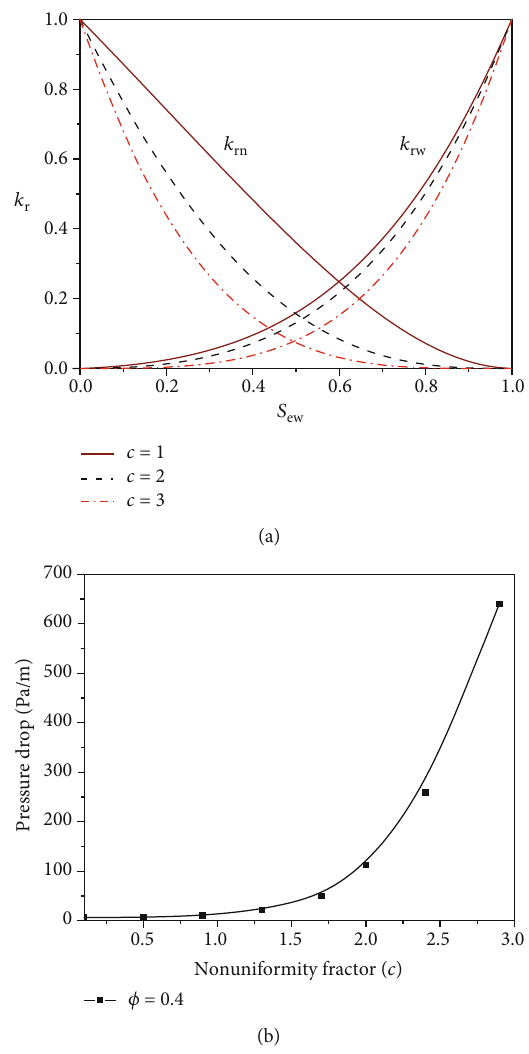
Figure 9: The e ff ect of nonuniformity factor c on the relative permeability of porous media and pressure drop ( μ = 0 : 8937 × 10 − 3 Pas , 25 ° C, r = 1 × 10 − 3 m , v = 1 × 10 − 3 m/s , τ = 1 : 5 s